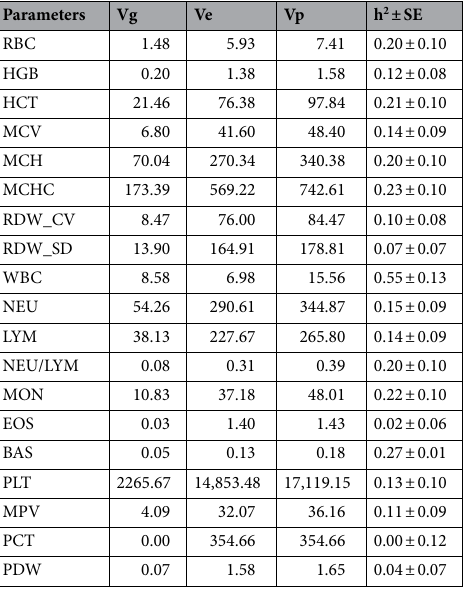
Table 2. Variance components and genomic heritability (h 2 ) estimates for the traits. Vg is additive genetic variance; Ve is residual variance; Vp is total phenotypic variance; h 2 is genomic heritability; SE is standard